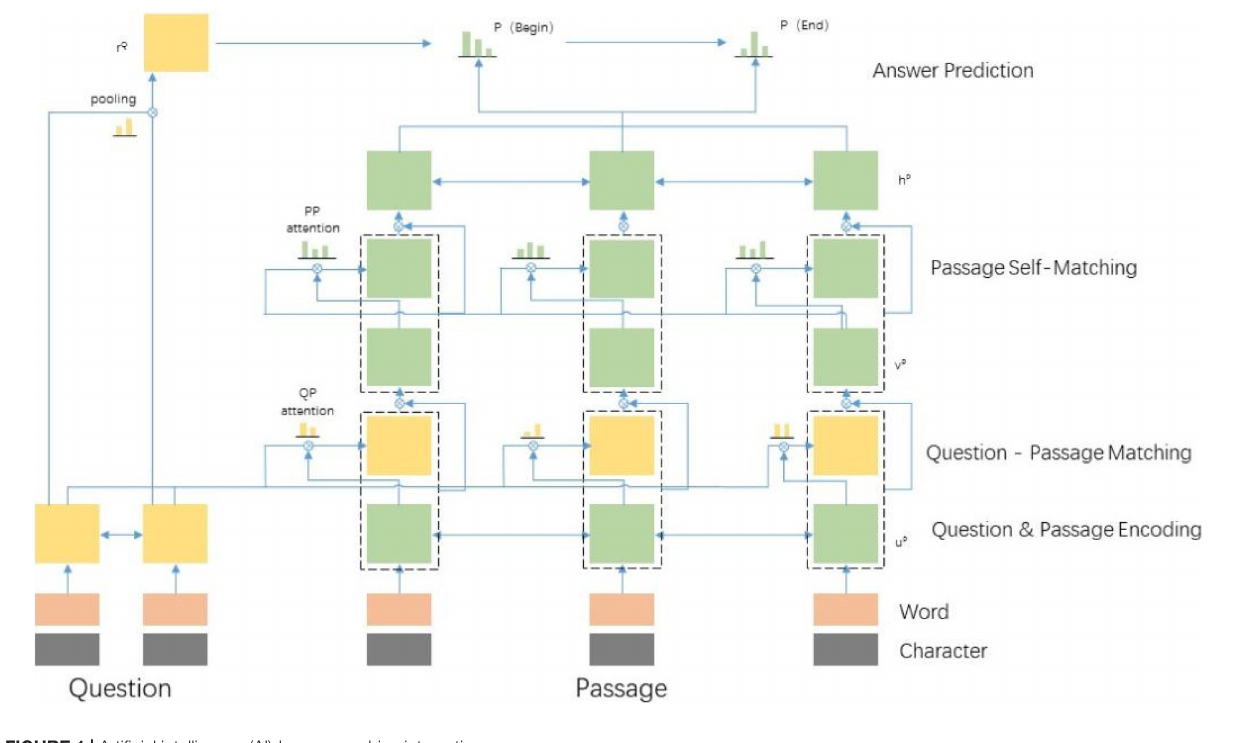
FIGURE 1 | Artificial intelligence (AI)-human machine interaction.